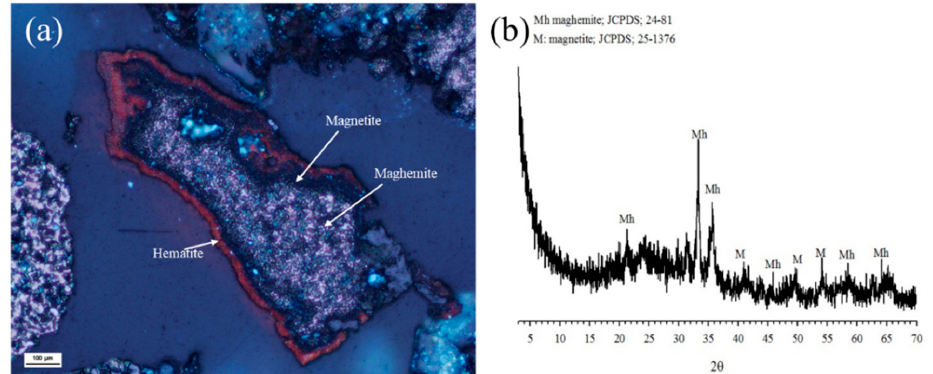
Figure 4. ( a ) Reflected light microphotograph showing mineral phase change from hematite to magnetite and maghemite. ( b ) X ‐ ray diffraction pattern of the magnetic fraction from the roasted sample. The sample was treated with 5 kW of microwave power in Exps. C.